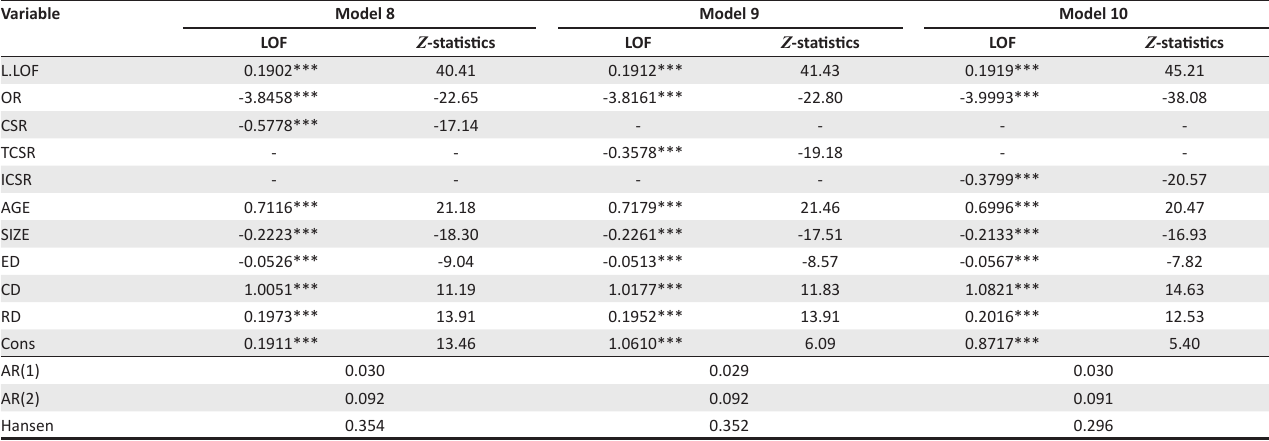
TABLE 4: Test of mediating effect. Variable